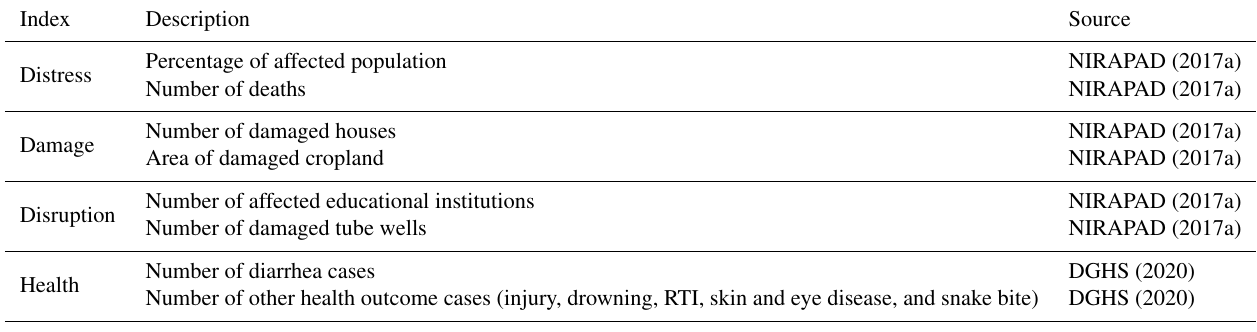
Table 3. Flood impact indices and variables considered for the August 2017 flood event.